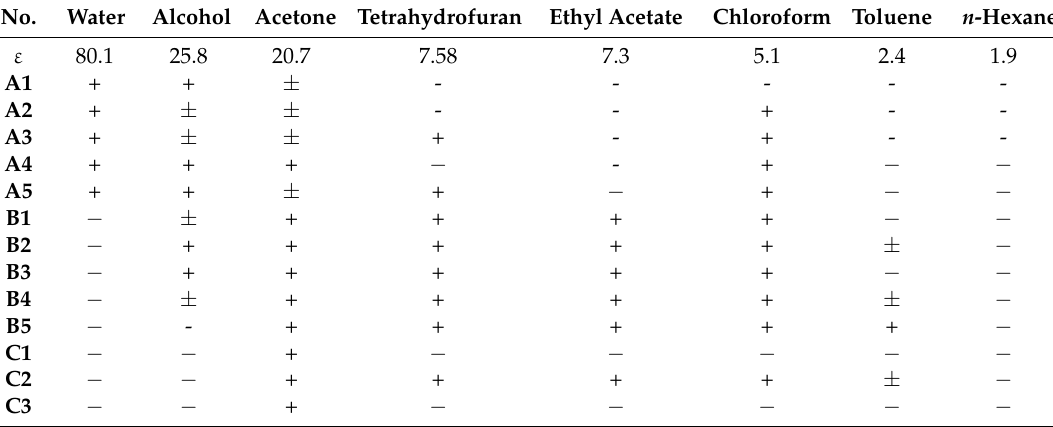
Table 3. The solubility of the 13 ionic liquids in various common